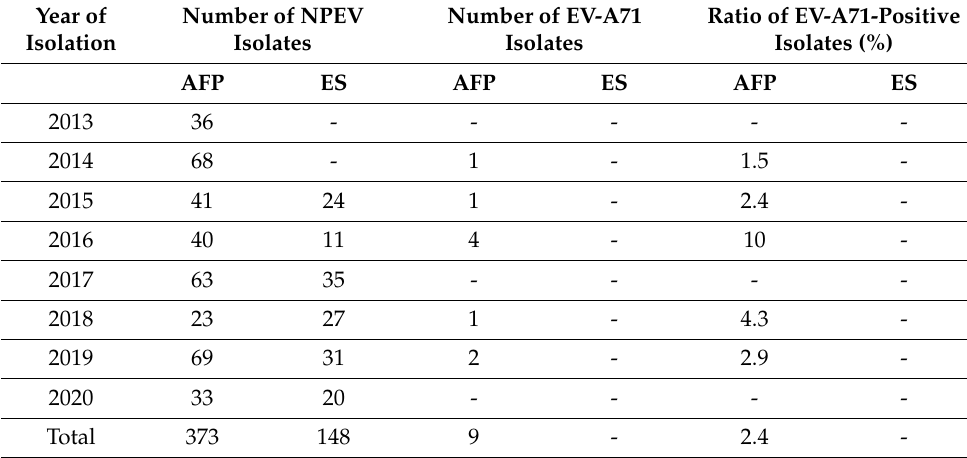
Table 1. Yearly distribution of NPEV and EV-A71 detected in AFP and environmental surveillance programs from 2013 to